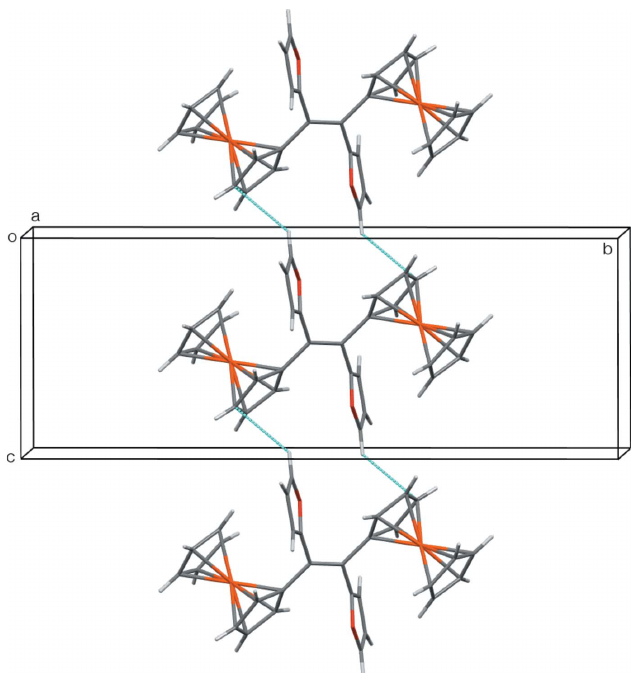
Figure 3 The ladder motif running parallel to [001] formed by the C3—H (cid:3)(cid:3)(cid:3) (cid:2)